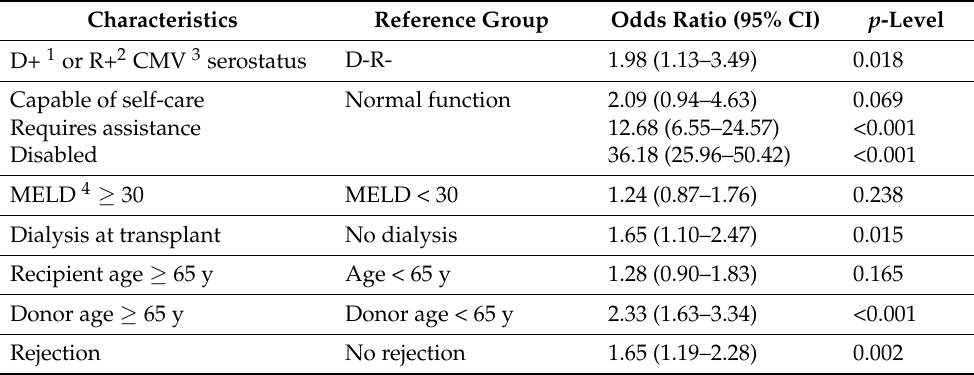
Table 6. Association of functional status at last follow-up with infection as a cause-of-death in patients who died. Patients with functional impairment were significantly more likely to have infections as cause-of-death compared to those with normal functional